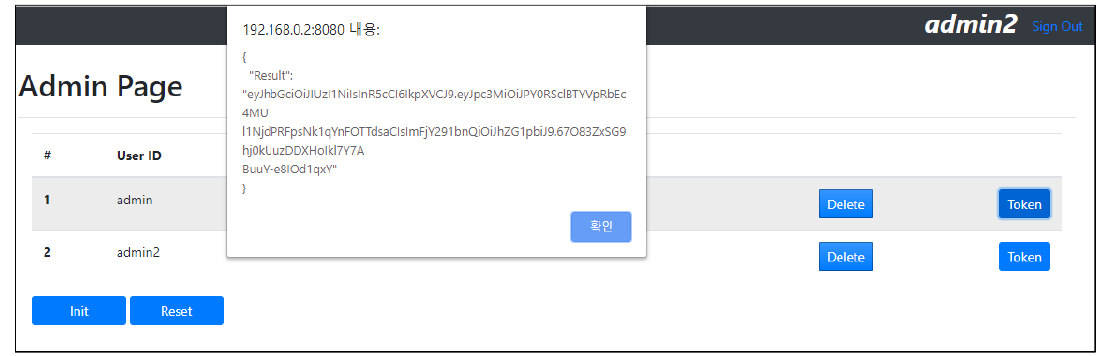
Figure 12. Result of obtaining a token using the getToken